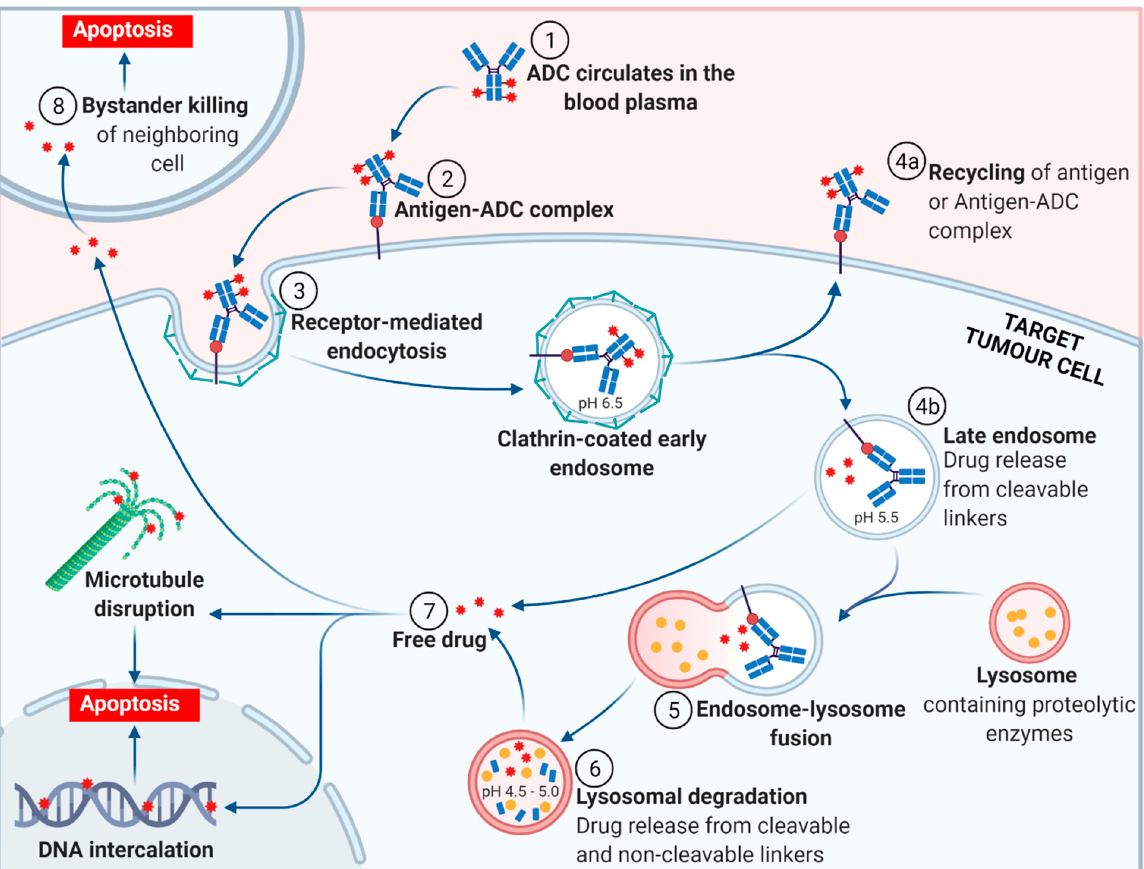
Figure 3. The general mechanism of action of an antibody-drug conjugate (ADC). (Adapted from “Antibody-Drug Conjugate Release”, by BioRender.com (accessed 27 September 2021). Retrieved from https://app.biorender-templates, accessed 27 September